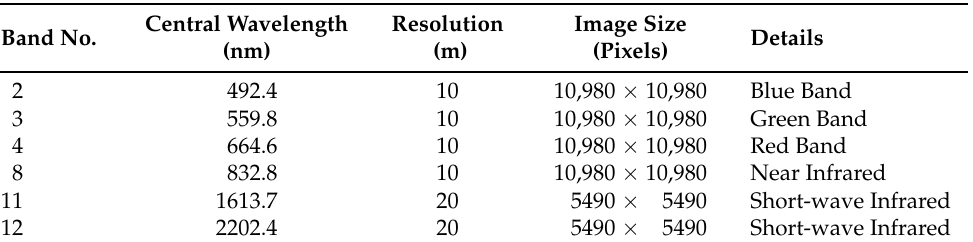
Table 1. Description of the spectral bands from Sentinel-2A [40] that were used as input in our study. The spectral bands of its twin satellite, Sentinel-2B, also had the same resolution for the respective bands and only varied in the central wavelength by a small fraction. Data from both Sentinel-2 satellites were used in our study without any distinction regarding their source.